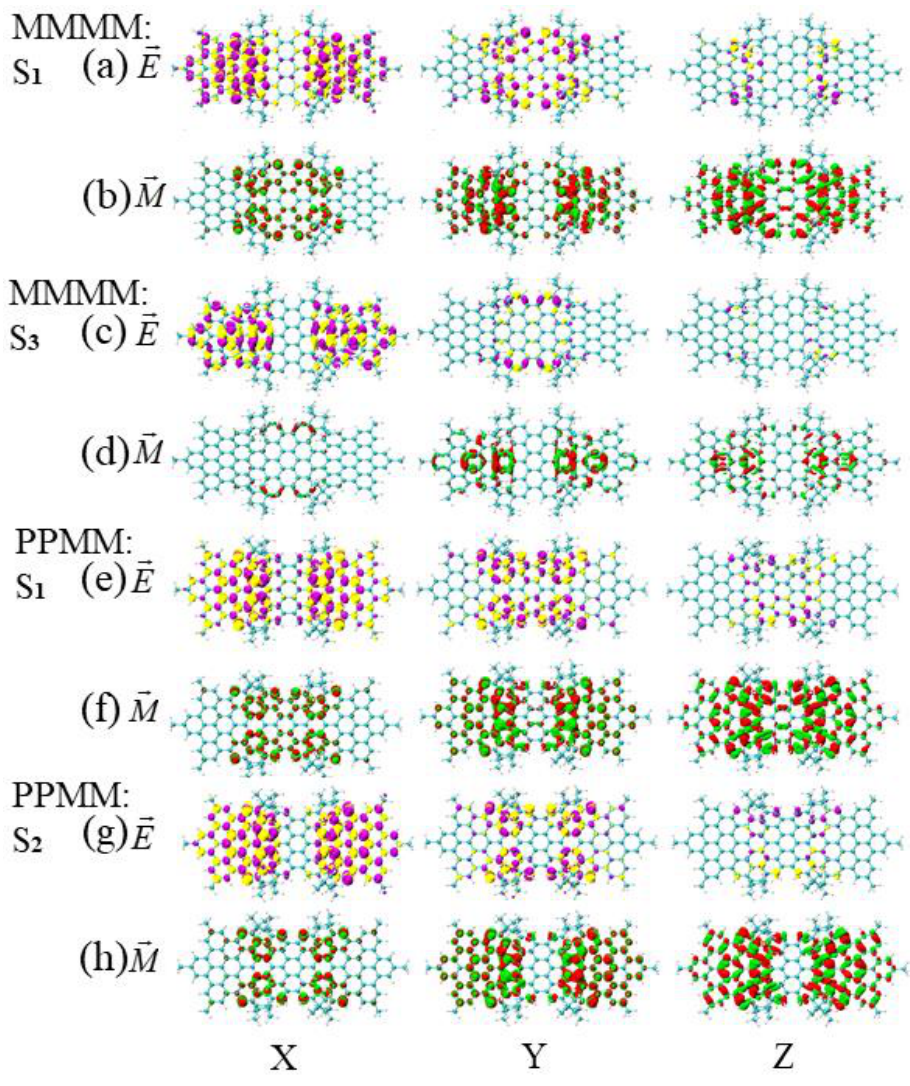
Figure 11. The TEDM and TMDM at similar wavelengths for asymmetric isomers (MMMM) and symmetric diastereomers (PPMM). ( a , b ) are distributed as the TEDM and TMDM in the x/y/z/direction of S1 of MMMM near the wavelength of 477 nm; ( c , d ) are distributed as the TEDM and TMDM in the x/y/z direction of S3 of MMMM near the wavelength of 438 nm; ( e , f ) are distributed as the TEDM and TMDM in the x/y/z direction of S1 of PPMM near the wavelength of 472 nm; ( g , h ) are distributed as the TEDM and TMDM in the x/y/z direction of S2 of PPMM near the wavelength of 444 nm. The letters E and M in the figure indicate the TEDM and TMDM of the molecule, respectively.